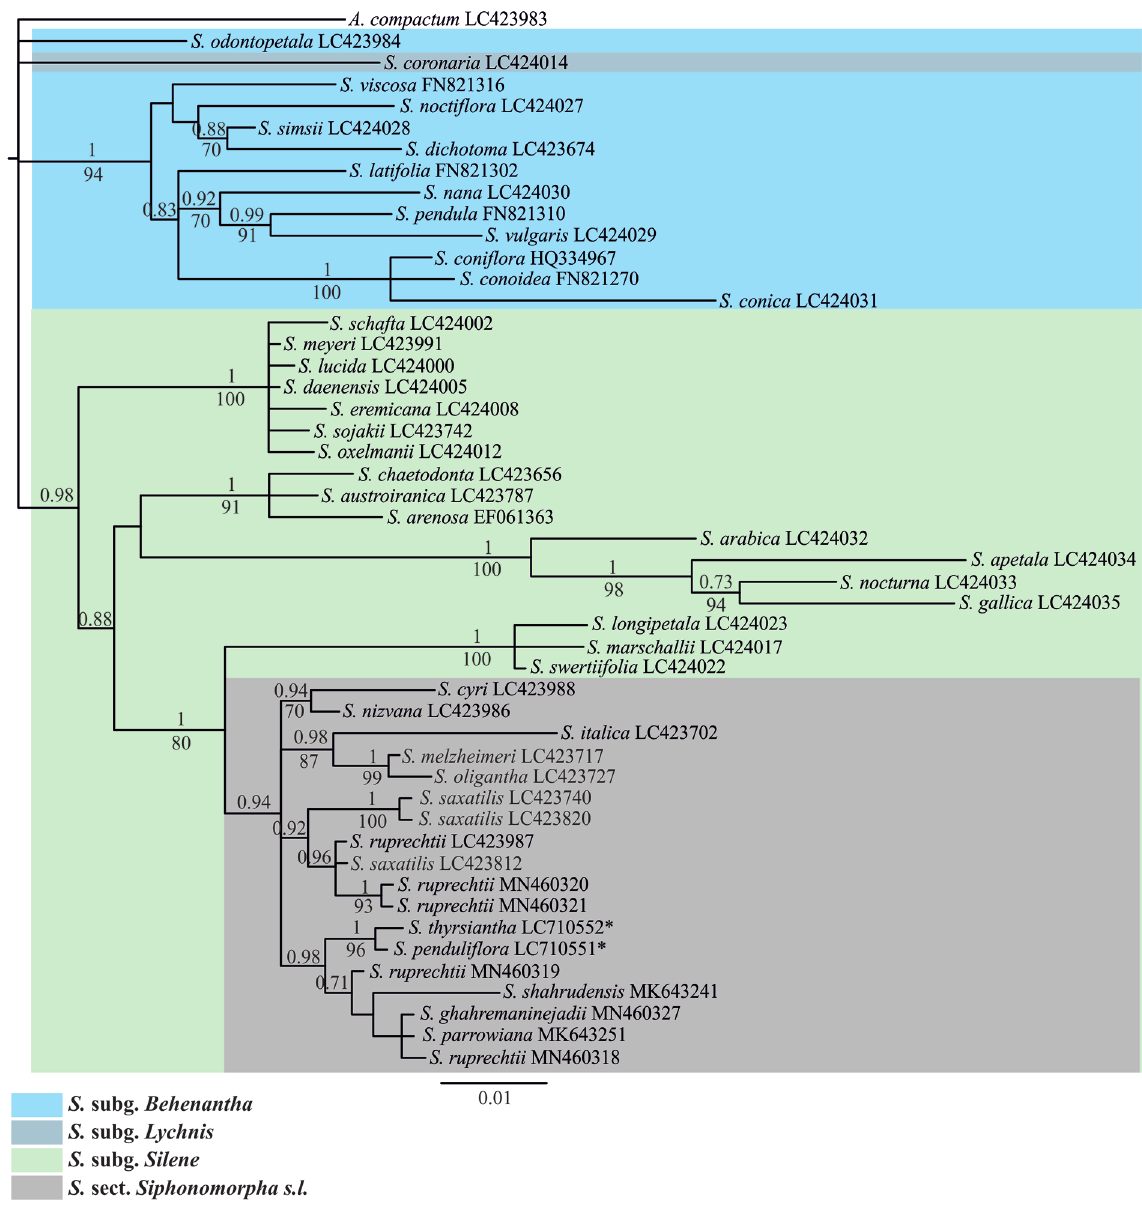
Fig. 2. 50% majority-rule consensus tree obtained from the Bayesian inference analysis of the cpDNA rps16 sequences in selected species of Silene L. Posterior probabilities (PP) ≥ 0.70 are shown above the branches and Maximum likelihood bootstrap (MLB) values ≥ 70% below. Accessions newly sequenced are indicated by a star. Accessions of S. ruprechtii Schischk. (MN460318 and MN460319) are misidentified by Bahmani et al.